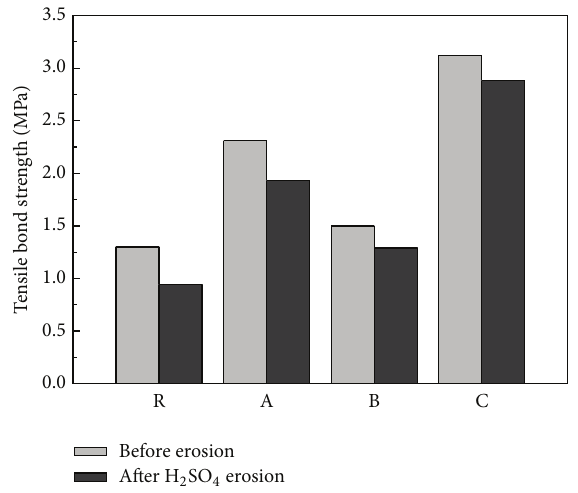
Figure 3: Tensile bond strength of repair mortars before and after erosion by 5% H 2 SO 4